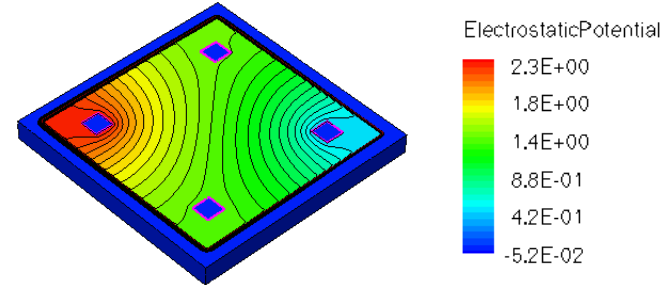
Figure 12. Electrostatic potential (V) for optimum structure, B = 0.5